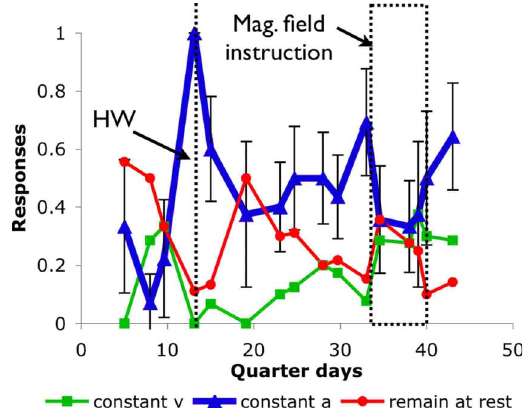
FIG. 5. (cid:1) Color online (cid:2) Responses by day on a question about the subsequent motion of a charge placed at rest in a uniform field. The correct answer (cid:1) blue and bold (cid:2) increases dramatically and falls rap- idly. Later, during the unit on magnetic forces and fields, there may be an interference dip. Some minor responses have